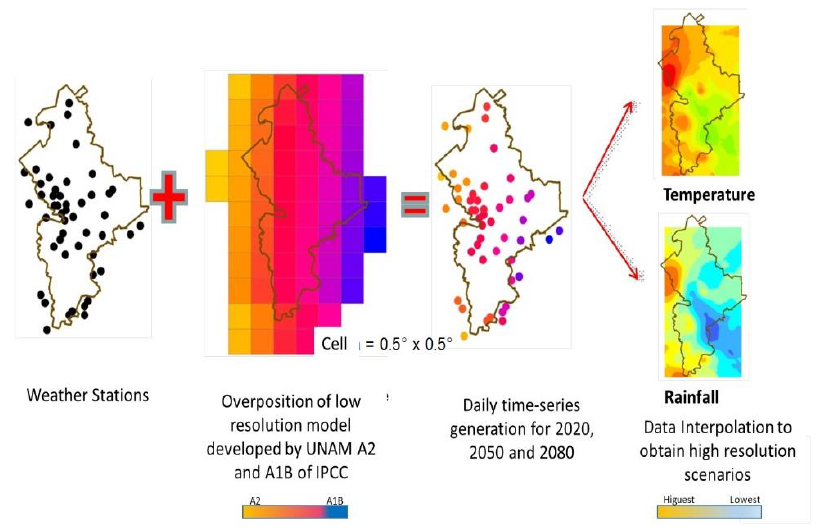
Figure 2. Modeling scheme for climate change in the State of Nuevo León, in 2020, 2050, and 2080. Model A2 in orange and AIB in blue.